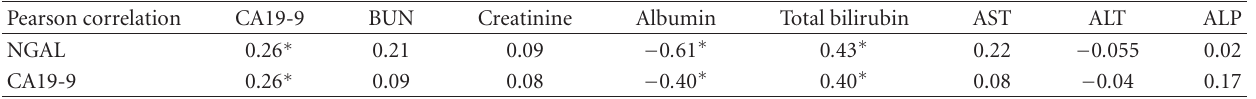
Table 2: Pearson’s correlation coe ffi cients of NGAL, CA19-9, BUN, creatinine, albumin, total bilirubin, AST, ALT and ALP.